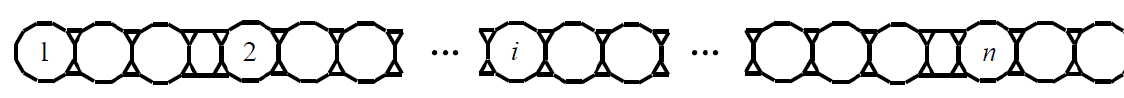
Figure 3: The Para-Line graph of linear [ s ]